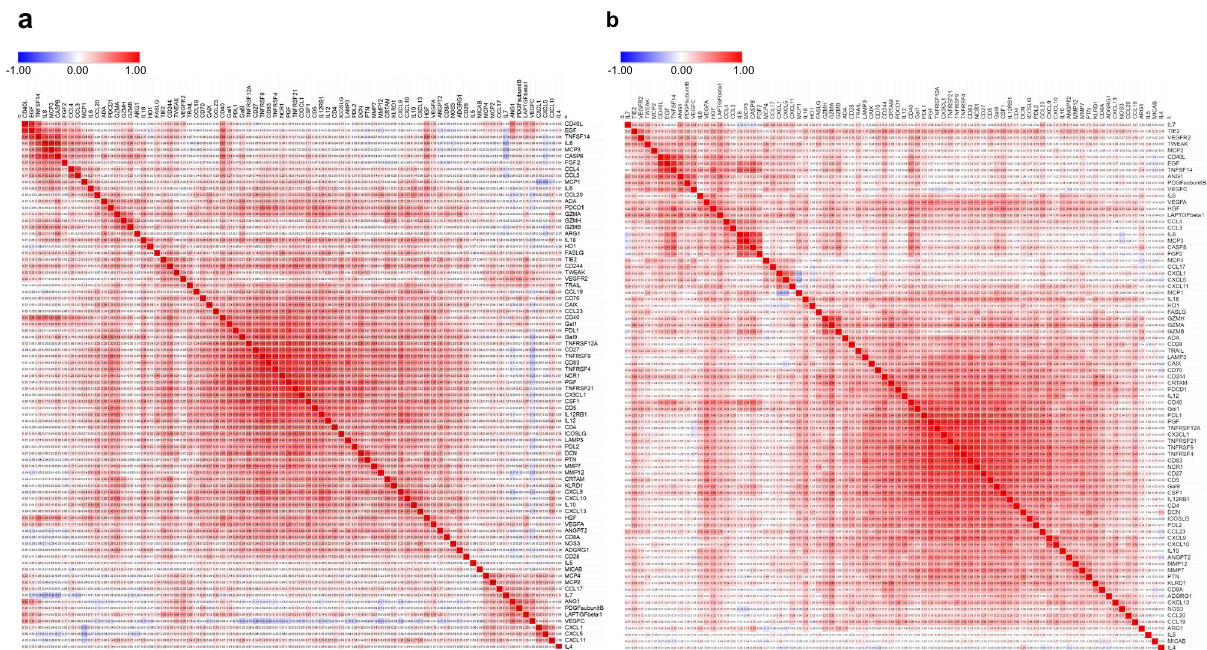
Fig. 1 Correlation matrix presenting Pearson pairwise correlations for each of the 82 serum protein pairs in African American men. Pearson pairwise correlations were estimated for each serum protein pair in African American ( a ) population controls ( n = 374) and ( b ) prostate cancer cases ( n = 394). Source data are provided as a Source Data fi le.